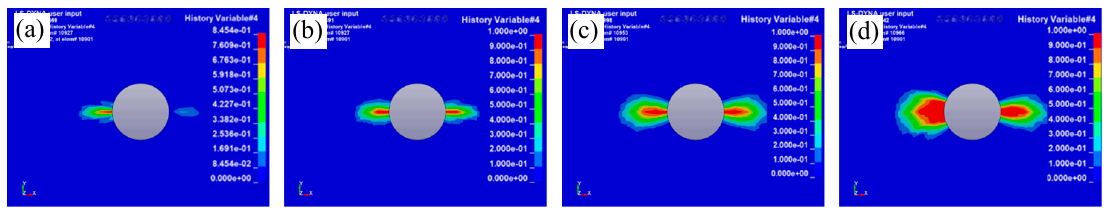
Figure 17. Damage variation of cumulative blasting. ( a ) t = 18.469 μ s; ( b ) t = 22.491 μ s; ( c ) t = 33.998 μ s; ( d ) t = 108.42 μ s.